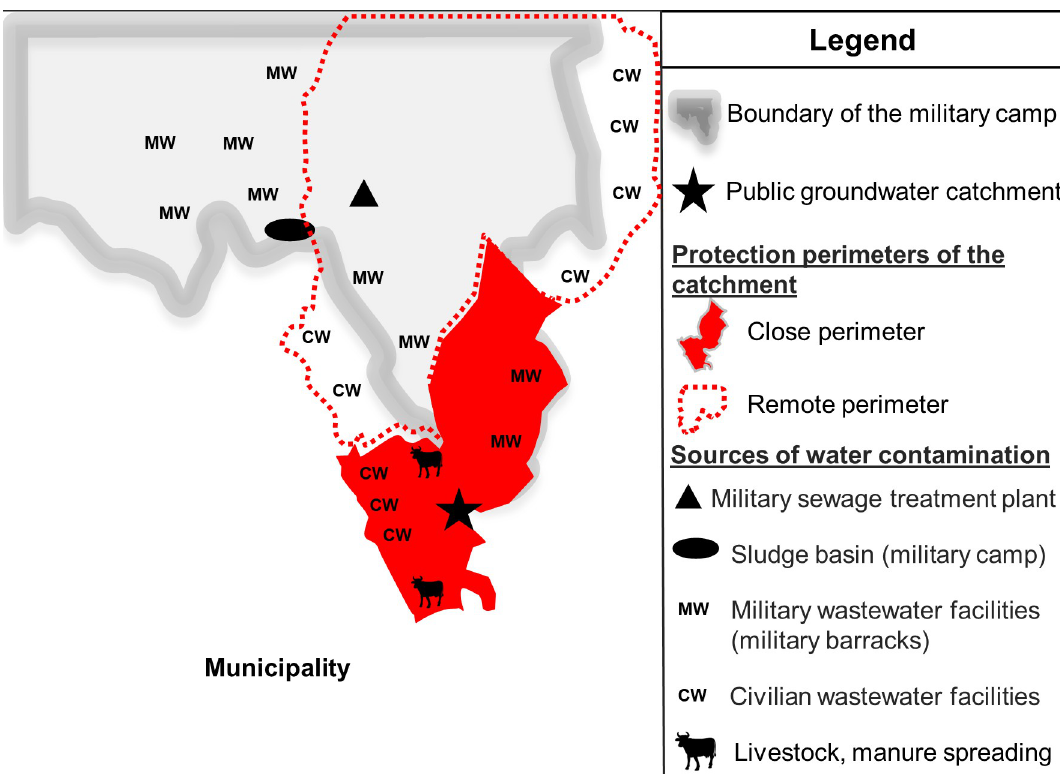
Fig 3. Cryptosporidiosis outbreaks, potential sources of contamination of the water resource (catchment), France, 2017.